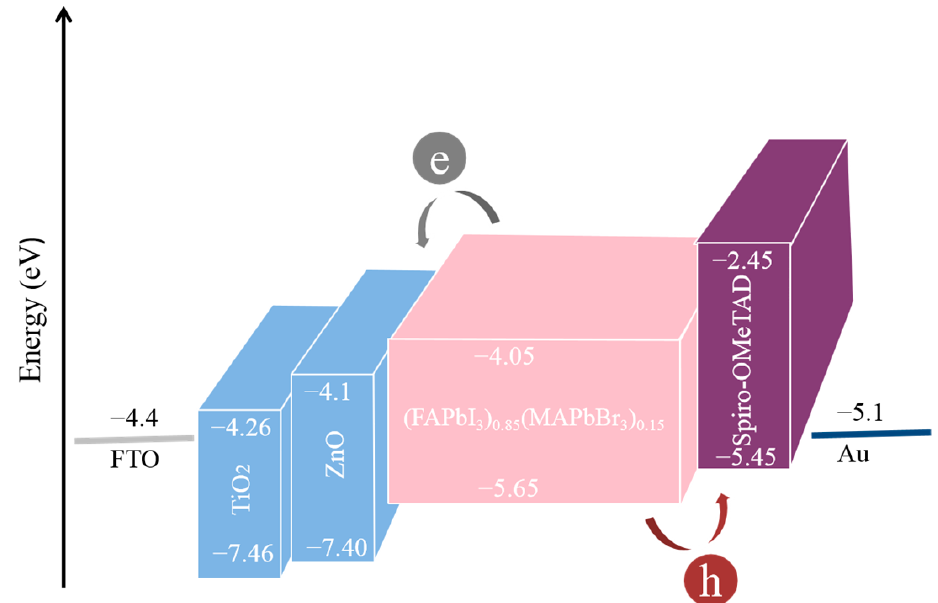
Figure 2. Energy level diagram.